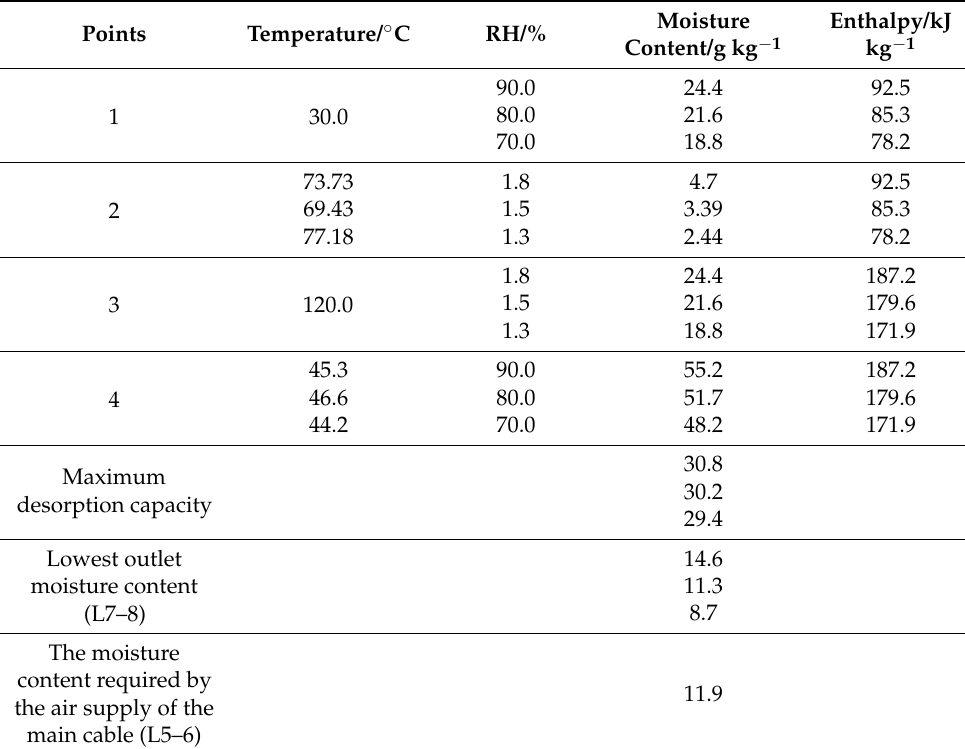
Table A2. Calculation result at inlet air temperature of 30 ◦